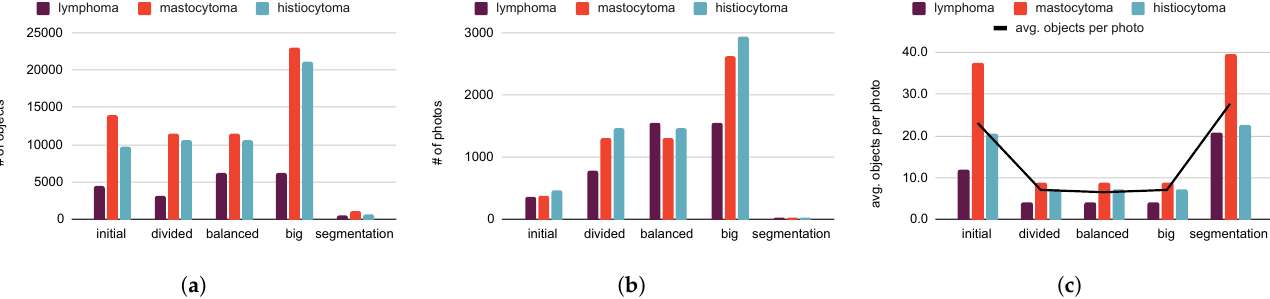
Figure 5. Datasets comparison. ( a ) Total number of objects in each class. ( b ) Total number of photos in each class. ( c ) Objects per photo in each